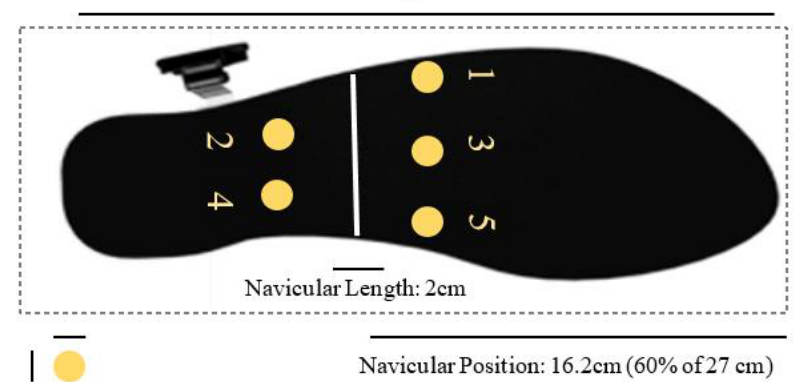
Figure 4. Sensor placement and numbering on the insoles.